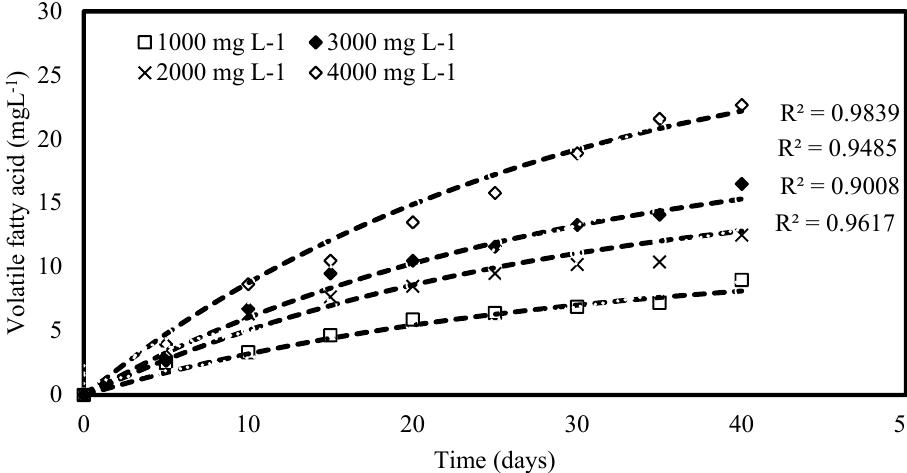
Figure 1. Time profiles of the VFA concentration during RPME mesophilic anaerobic degradation at different initial wastewater concentrations (in terms of mg VFA L − 1 ). Symbols refer to the experimen- tal data, and dash lines refer to the predictions by using Equation (2) with k = 0.0356 ± 0.004 day − 1 and α = 0.206 ± 0.0084 g VFA g VSS − 1 . Table 2. Parameters for the kinetic study of anaerobic digestion phases. Feeding Concentration, (mg